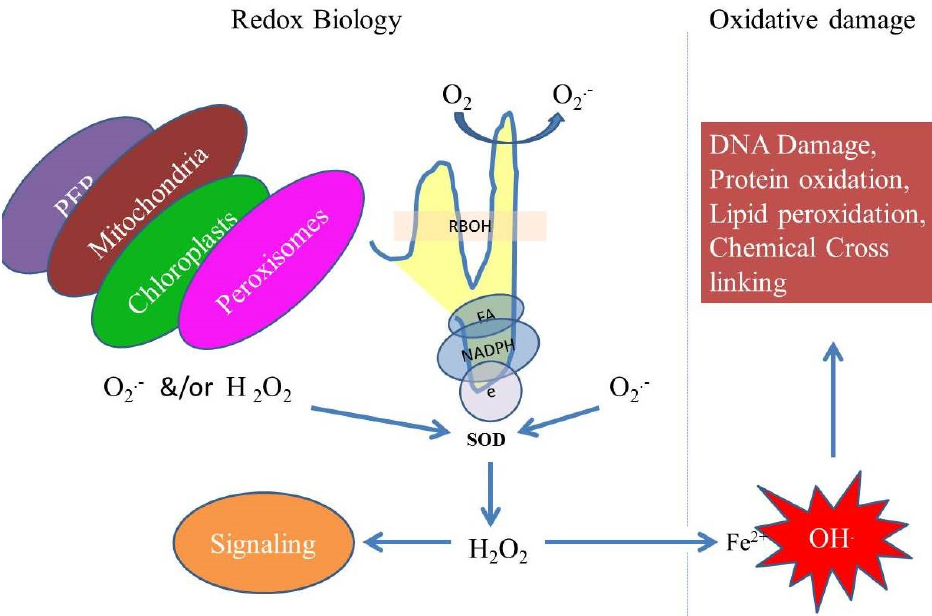
Figure 4. Integration of ROS and redox biology in cellular processes. Different cell organelles, including mitochondria, chloroplasts, peroxisomes and cell-wall-bound peroxidases (PER) and respiratory burst oxidase homologs (RBOHs), produce ROS that accumulate in the form of hydrogen peroxide (H 2 O 2 ), resulting in the mediation of cell-to-cell signaling pathways. However, the presence of Fe 2+ ions can cause cellular oxidative stress via hydroxyl radicals. These processes must be balanced and are crucial for redox biology for the regulation of the metabolism and other physiological and cellular functions.